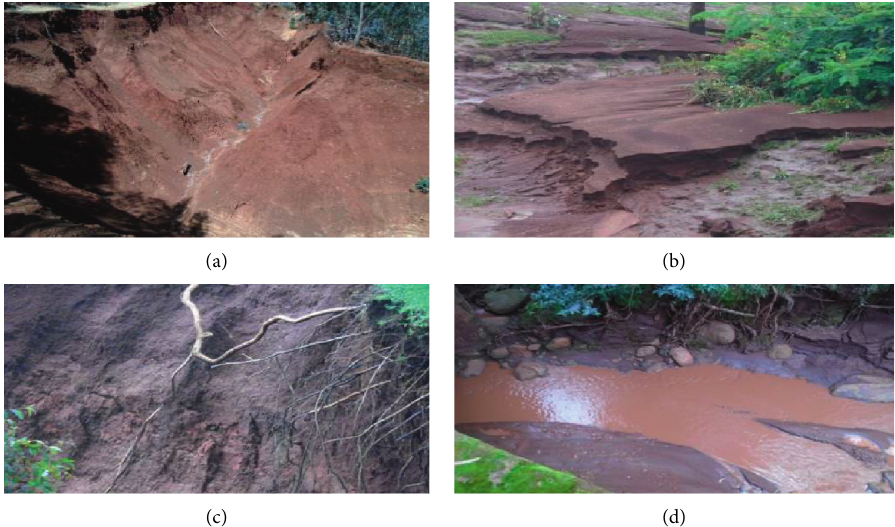
Figure 7: (a) Deep gully, (b) sediment at the bottom slope, (c) tree root exposure, and (d) river water polluted with eroded soil in Shenkolla watershed (source: photo taken during field work,